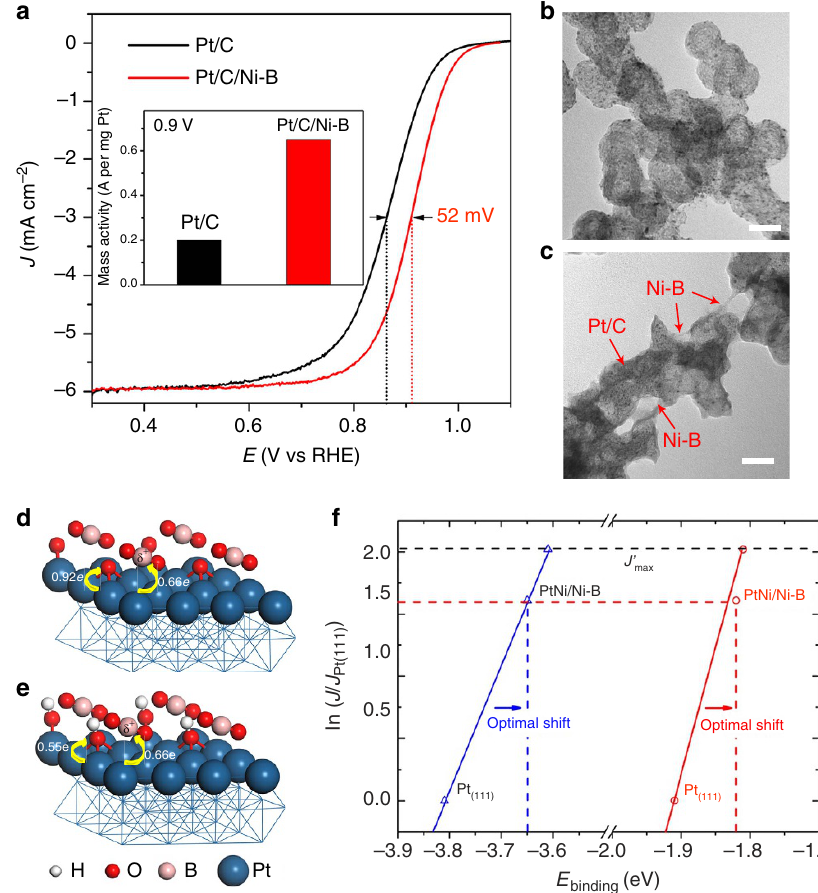
Figure 4 | Electrochemical properties of Pt/C/Ni–B and density functional theory analysis. ( a ) ORR polarization curves and (inset) mass activities of Pt/ C and Pt/C/Ni–B at 0.9V versus RHE. ( b , c ) TEM images of Pt/C ( b ) and Pt/C/Ni–B ( c ). ( d ) Adsorption of O on the hollow site of BO 2 /Pt(111), including valence state of B and electron transfer from Pt(111) to BO 2 and O. ( e ) Adsorption of OH on the hollow site of BO 2 /Pt(111), including valence state of B and electron transfer from Pt(111) to BO 2 and OH. ( f ) The experimental current density as a function of the calculated binding energy of O (blue) and OH (red), showing optimal shift in binding energy for the maximum ORR activity by the arrow. The nominal maximum J 0 max with respect to Pt(111) is deduced from the activity volcano for ORR proposed by Nørskov et al. Scale bars, 50